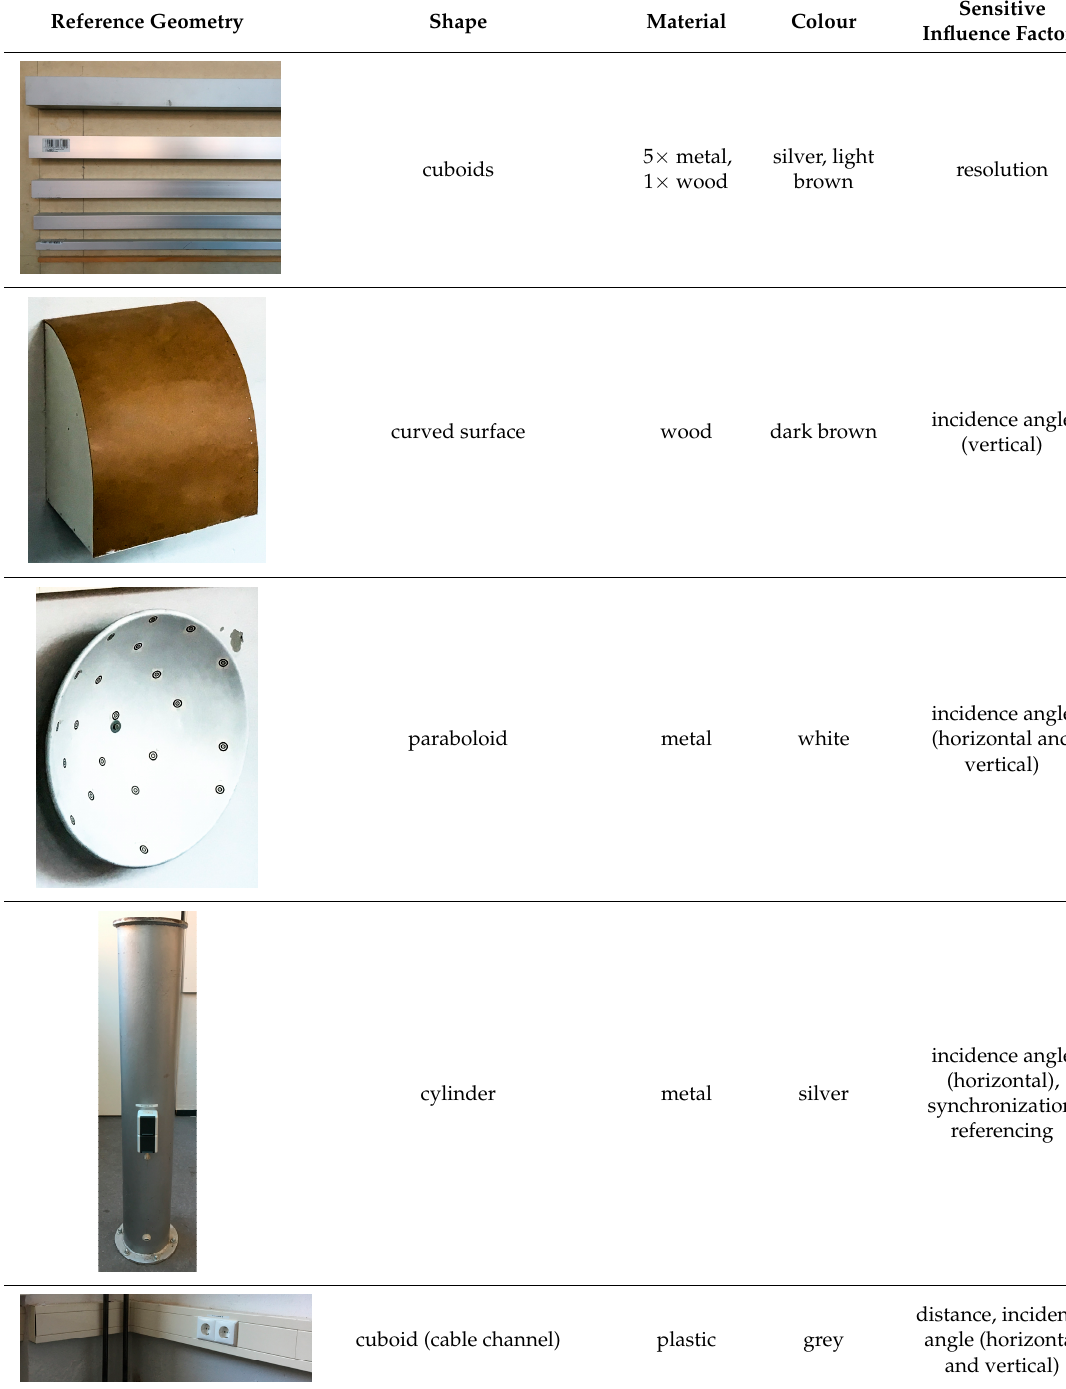
Table 2. Parameters of the reference geometries and the sensitive influence factors that can be detected.